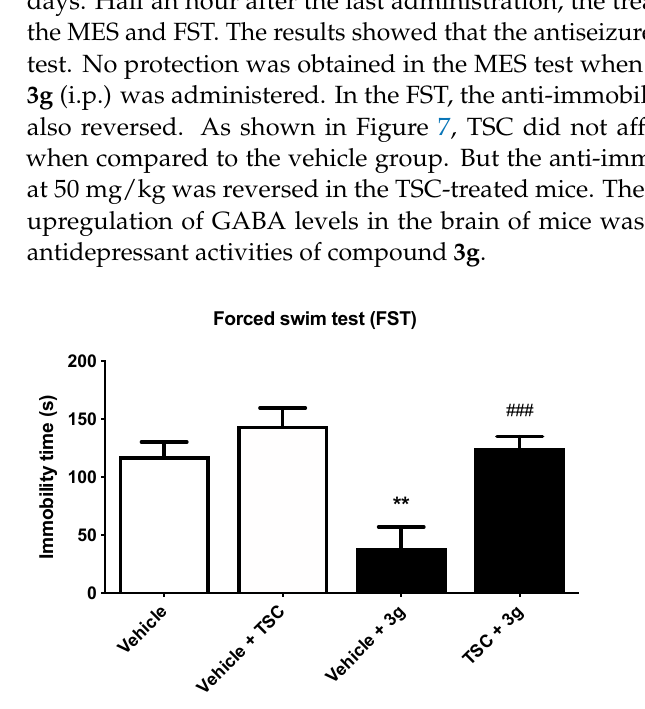
Figure 6. Effects of 3g , phenytoin, and FXT on whole brain GABA ( A ) and 5-HT ( B ) levels in mice brains. Eight animals were used for each group. * p < 0.05 compared to the control group, ** p < 0.01 compared to the control group.